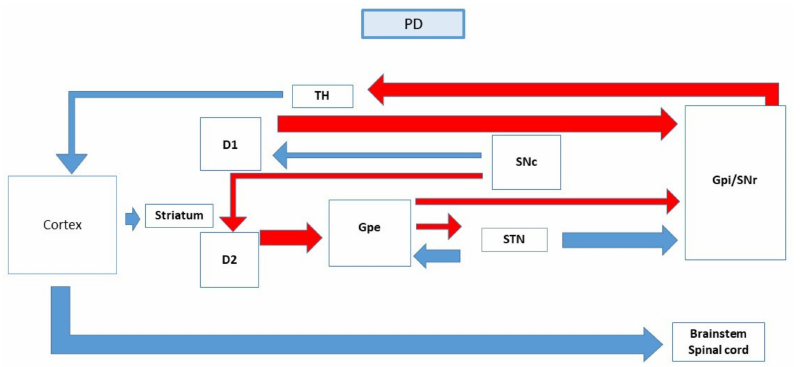
Figure 2. The schematic diagram of the basal ganglia and their connections in Parkinson’s Disease